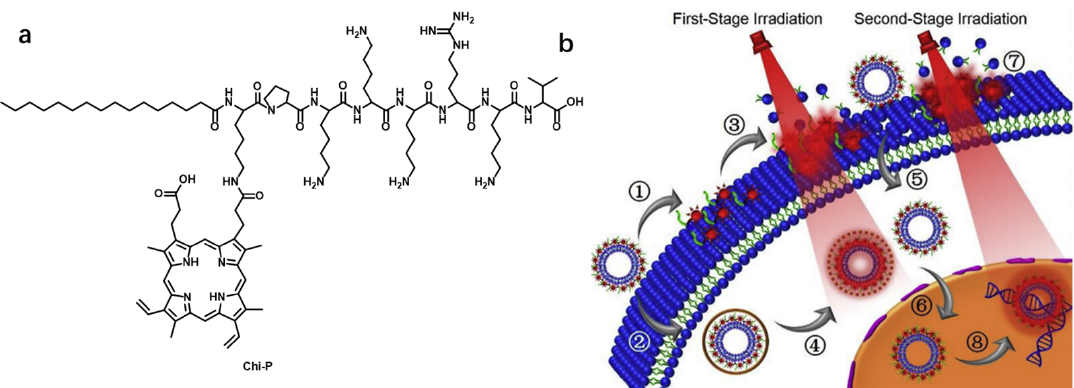
Figure 28. ( a ) Chemical structure of ChiP. ( b ) The proposed processes of ChiP-Exo for dual-stage light guided plasma membrane and nucleus-targeted PDT. ① Plasma membrane targeted delivery of Chip-Exo; ② The intracellular delivery of ChiP-Exo through endocytosis; ③ Plasma membrane fluctuation and ④ lysosomal escape of ChiP-Exo under the first-stage light irradiation; ⑤ Photo- chemical internalization (PCI) of ChiP-Exo; ⑥ Nucleus targeted translocation of ChiP-Exo; ⑦ Plasma membrane rupture and ⑧ nucleus destruction under the second-stage light irradiation.